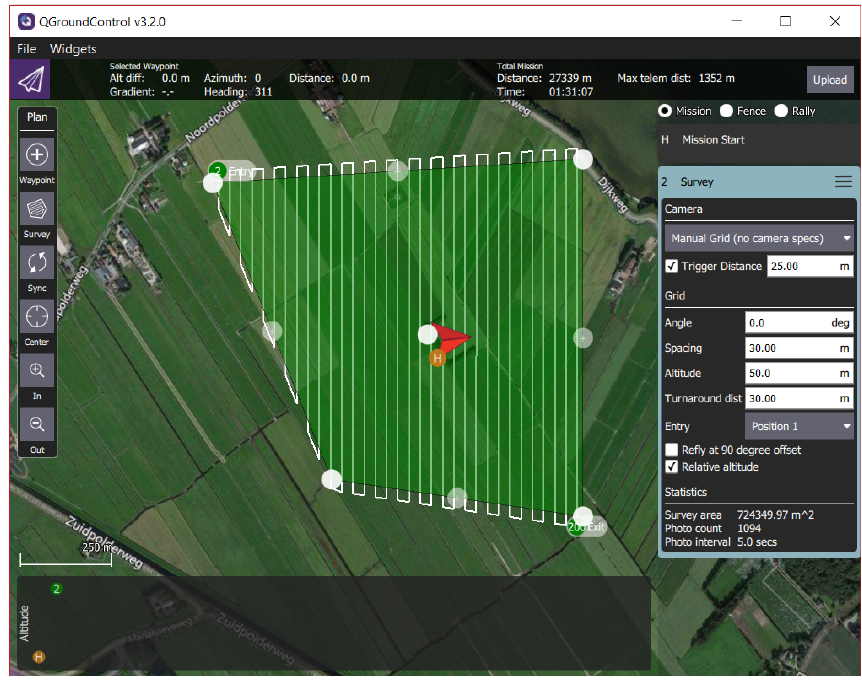
Figure 8. Graphical interface of QGroundControl with an example of the mission’s waypoints map. Source: www.qgroundcontrol.com, accessed on 27 March